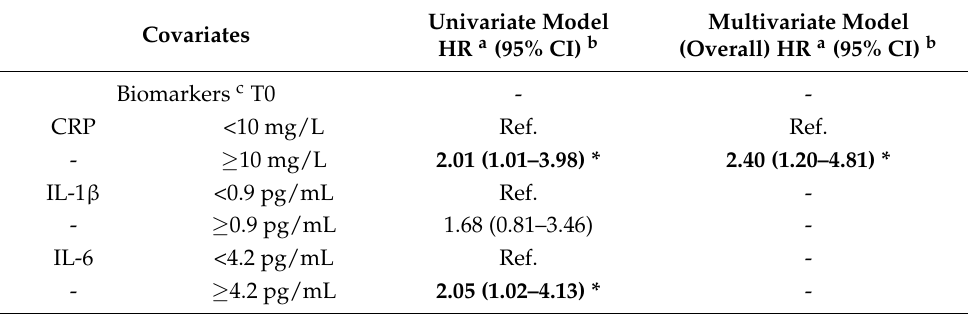
Table 3. Baseline variables related to overall survival until three years after surgery for patients with a colorectal tumor (univariate and multivariate Cox regression analysis; n =